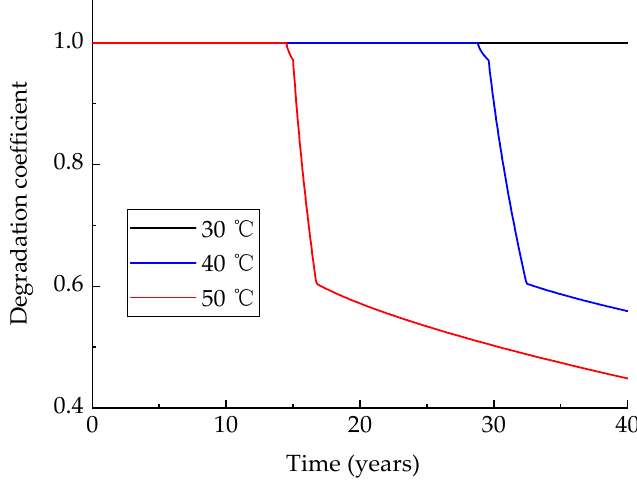
Figure 8. Variations in the degradation coefficient with time.